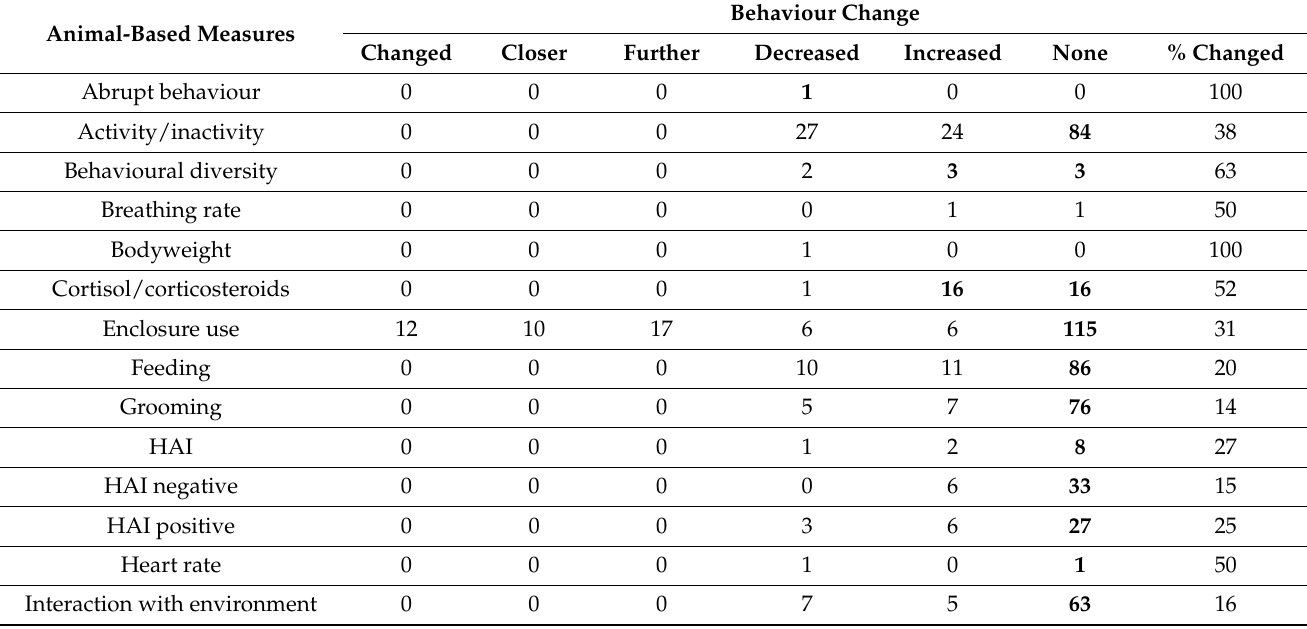
Table 3. An overview of animal-based measures and the direction of the behaviour change. The most frequent behaviour change category is highlighted in bold for each animal-based